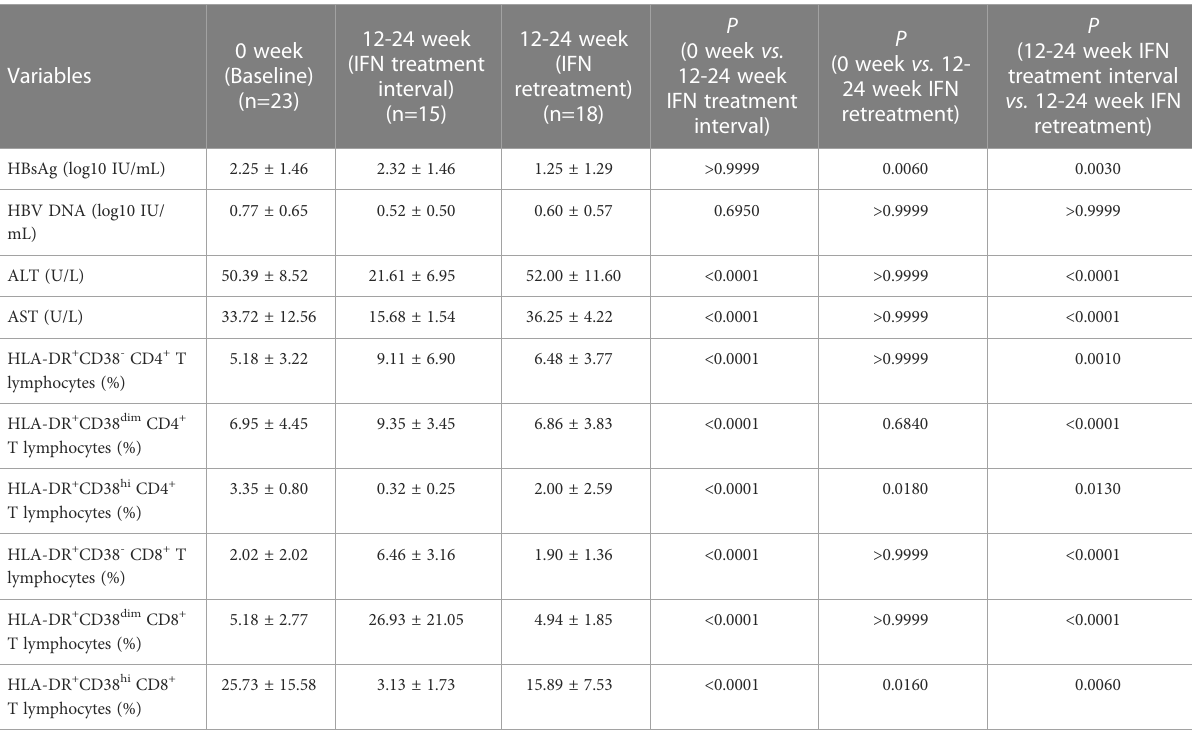
TABLE 3 The changes of indicators in Plateau group during IFN intermittent treatment and IFN retreatment a .